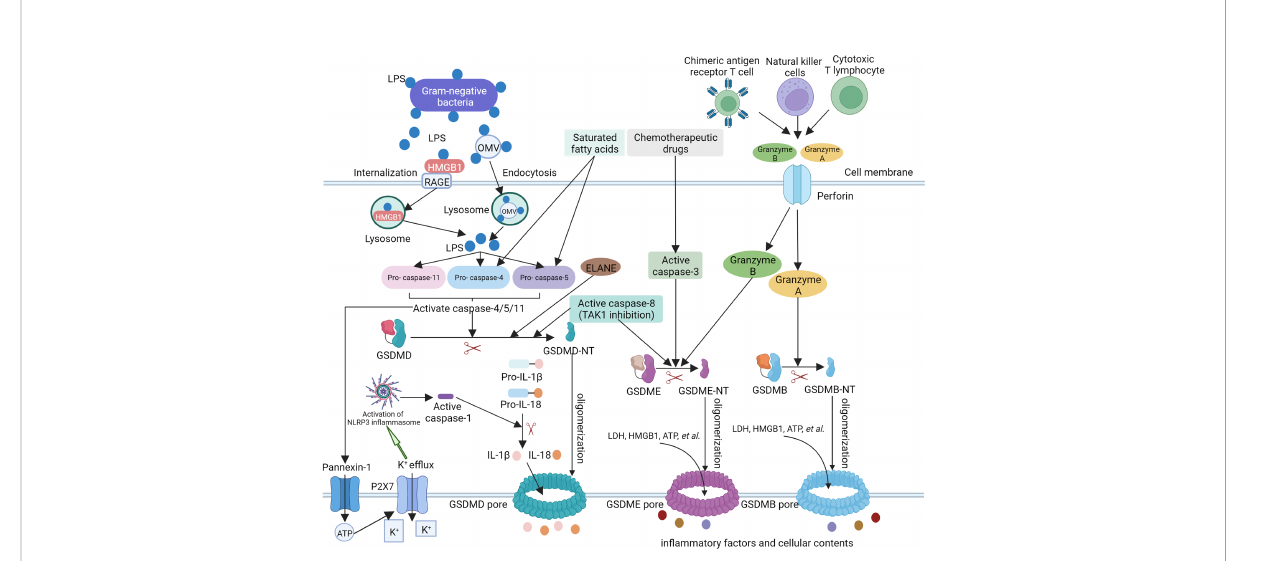
FIGURE 2 The molecular mechanism of non-canonical pyroptosis pathway and other pyroptosis